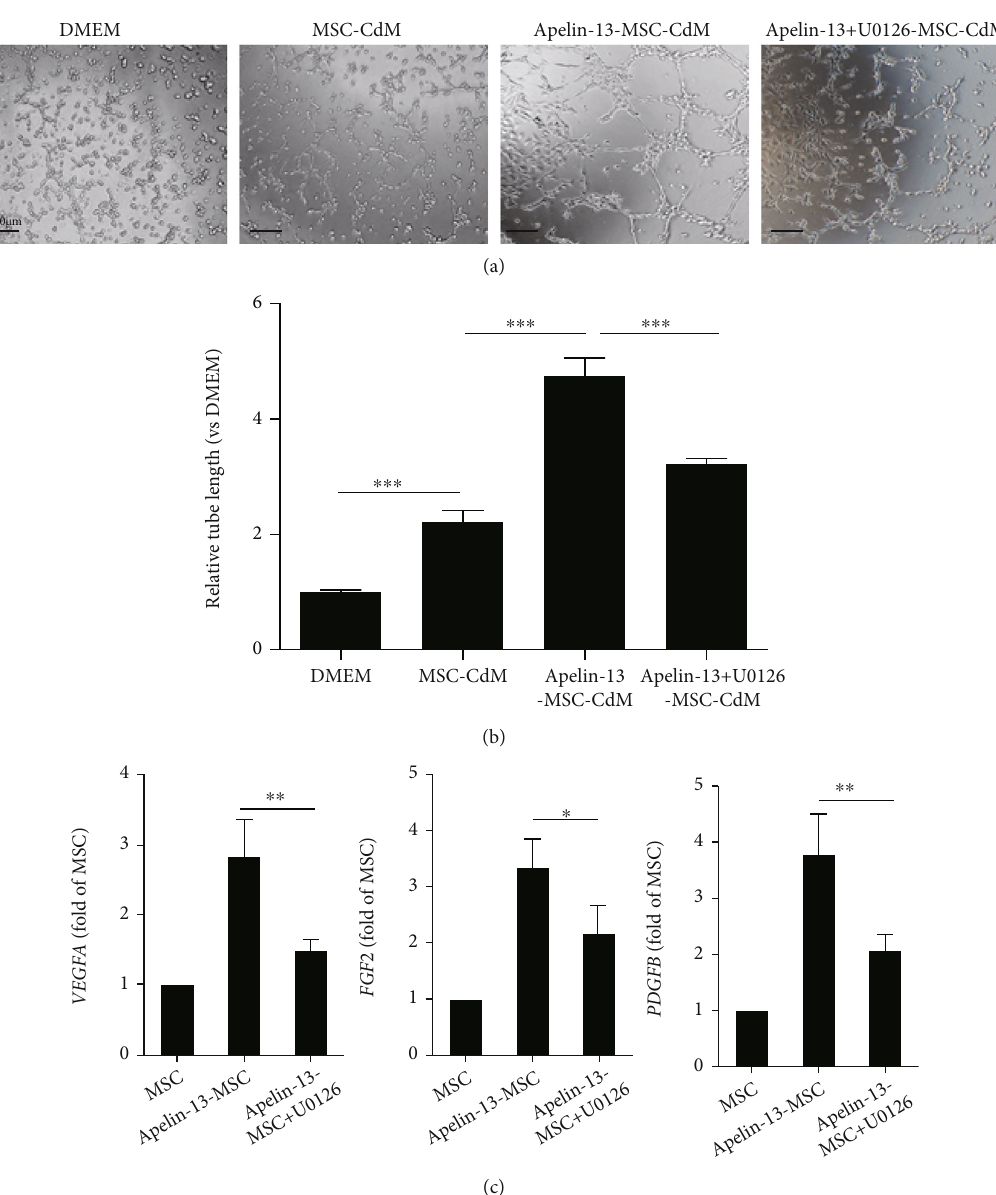
Figure 3: Apelin-13 pretreatment improves the angiogenic capacity of MSCs. (a) Representative light images of HUVEC tube formation assay in MSC-CdM, Apelin-13-MSC-CdM, and Apelin-13+U0126-MSC-CdM treatment. (b) Quantitative analysis of the HUVEC tube length in MSC-CdM, Apelin-13-MSC-CdM, and Apelin-13+U0126-MSC-CdM treatment. (c) Expression of proangiogenesis cytokines determined by qRT-PCR. n = 3 biological replicates for each group. Data are expressed as mean ± SD . ∗ p < 0 : 05 , ∗∗ p < 0 : 01 , ∗∗∗ p < 0 : 001